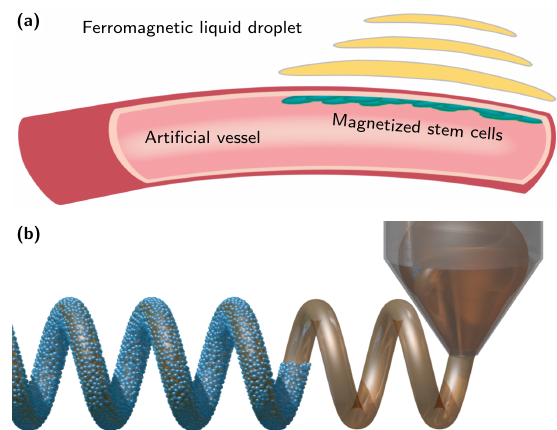
Figure 7. Technological perspective of ferromagnetic liquid droplets. ( a ) Adaptive directional tissue growth stimulated by magnetic fields of ferromagnetic liquids. ( b ) 3D printed ferromagnetic liquid components with arbitrary shape for magnetic-remote-controlled robotic